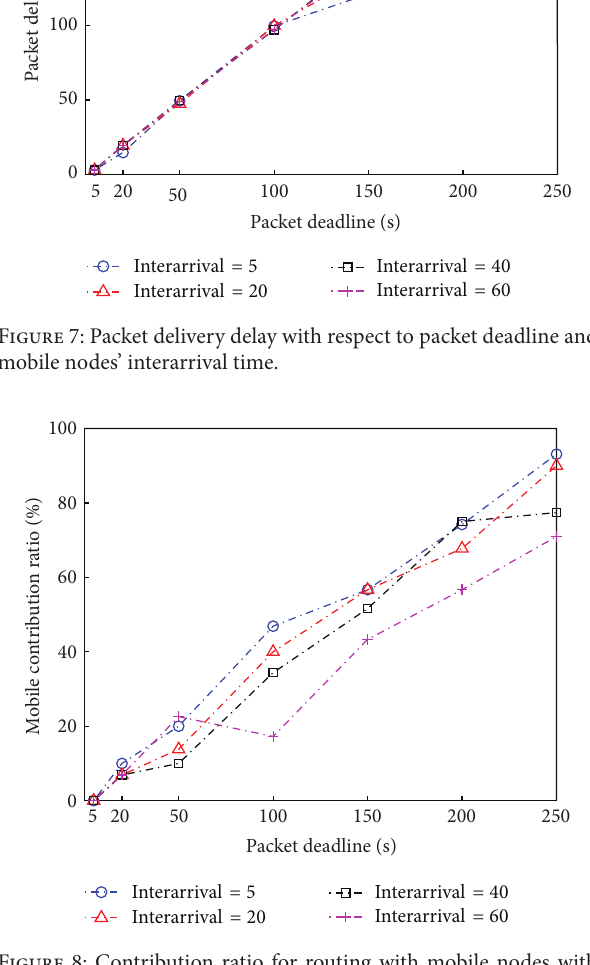
Figure 6: Packet delivery ratio with respect to packet deadline and mobile nodes’ interarrival time.